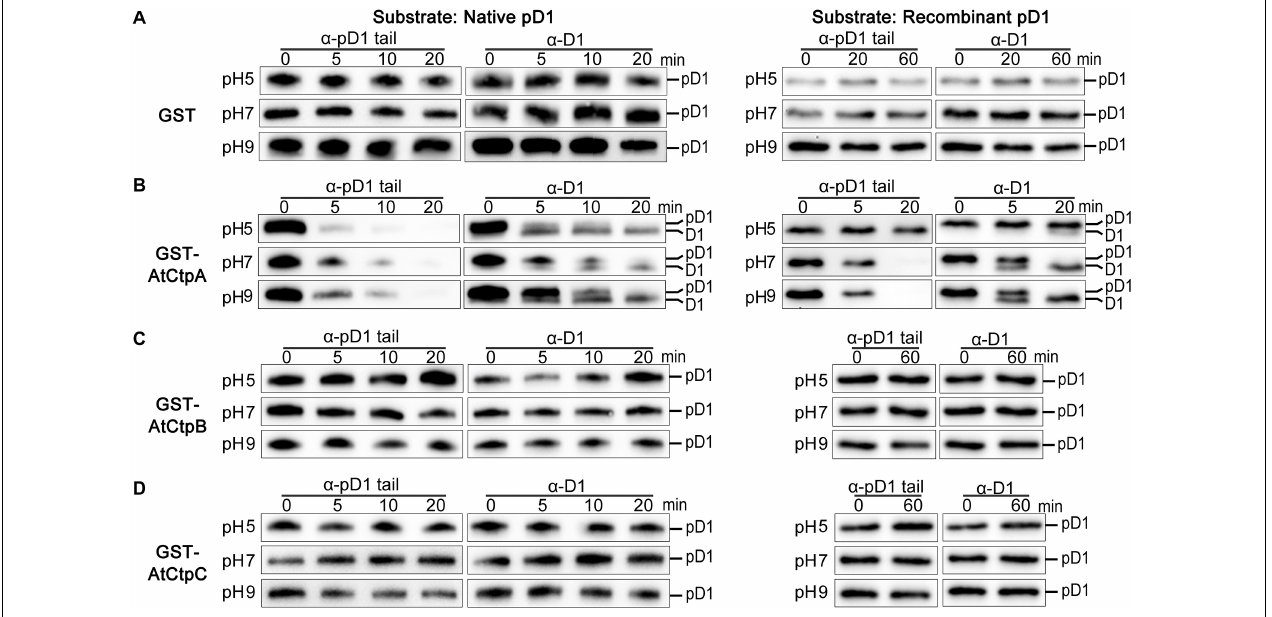
FIGURE 5 | In vitro analyses of the AtCtpA (B) , AtCtpB (C) , and AtCtpC (D) protease activities. In vitro protease activity of AtCtpA (B) , AtCtpB (C) , and AtCtpC (D) was assayed with the substrates native pD1 (Left) and recombinant pD1 (Right). Free GST (A) was used as negative control. Native pD1 was from 1% DM detergent-treated thylakoid membranes extracted from the atctpa mutant; recombinant pD1 was recombinant AtpD1 . Proteolytic reactions were performed as described in the legend of Figure 4